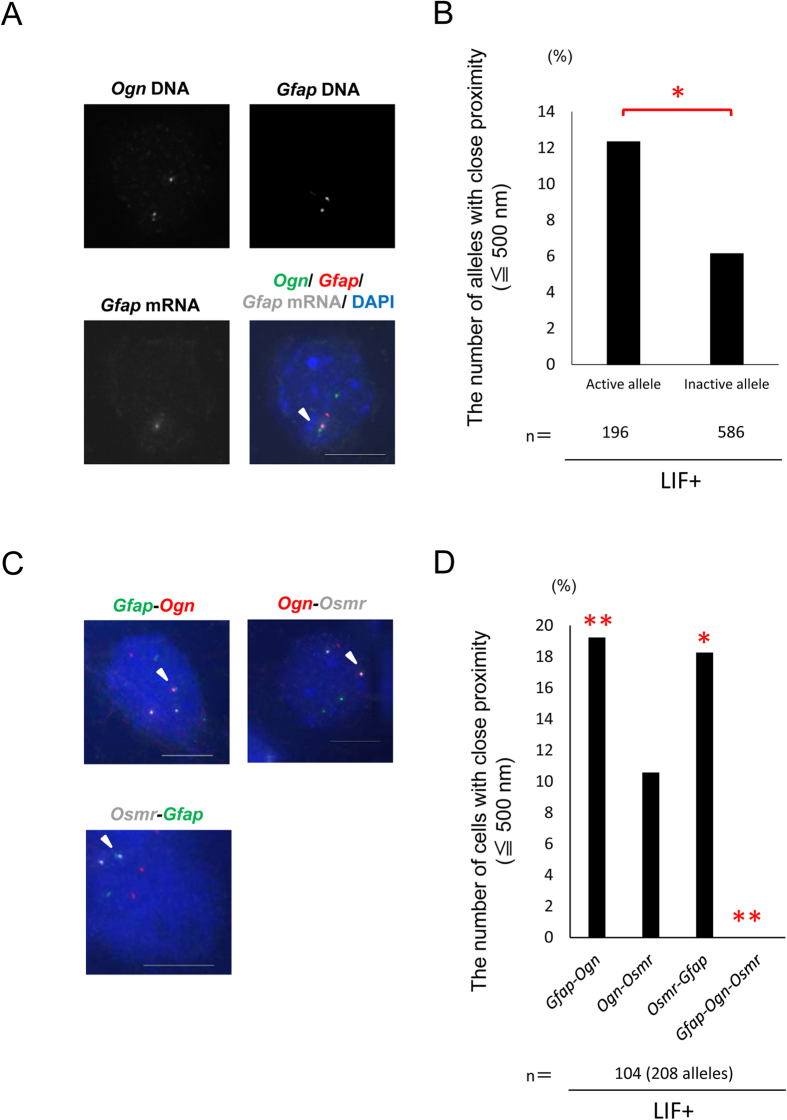
Detailed gene association analysis.(A) Projected images of triple-labeled RNA/DNA FISH in LIF+ cells for Ogn DNA (green), Gfap RNA (red), and Gfap DNA (white). Nuclei were counterstained with DAPI (blue). Scale bar = 5 μm. (B) Association frequencies of Gfap active alleles and inactive alleles determined with RNA/DNA FISH for LIF+ cells. *P < 0.05. (C) Projected images of triple-labeled DNA FISH in LIF+ cells for Gfap (green), Ogn (red), and Osmr (white). Nuclei were counterstained with DAPI (blue). Scale bar = 5 μm. (D) Association frequencies determined with DNA FISH for the indicated gene pairs in LIF+ cells. **P < 0.01, *P < 0.05.